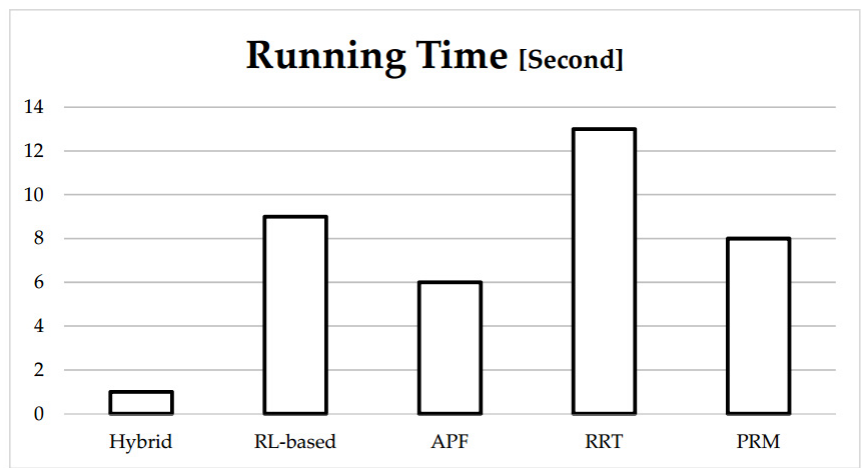
Figure 11. Comparison between running time of the hybrid method and other methods under the same conditions.